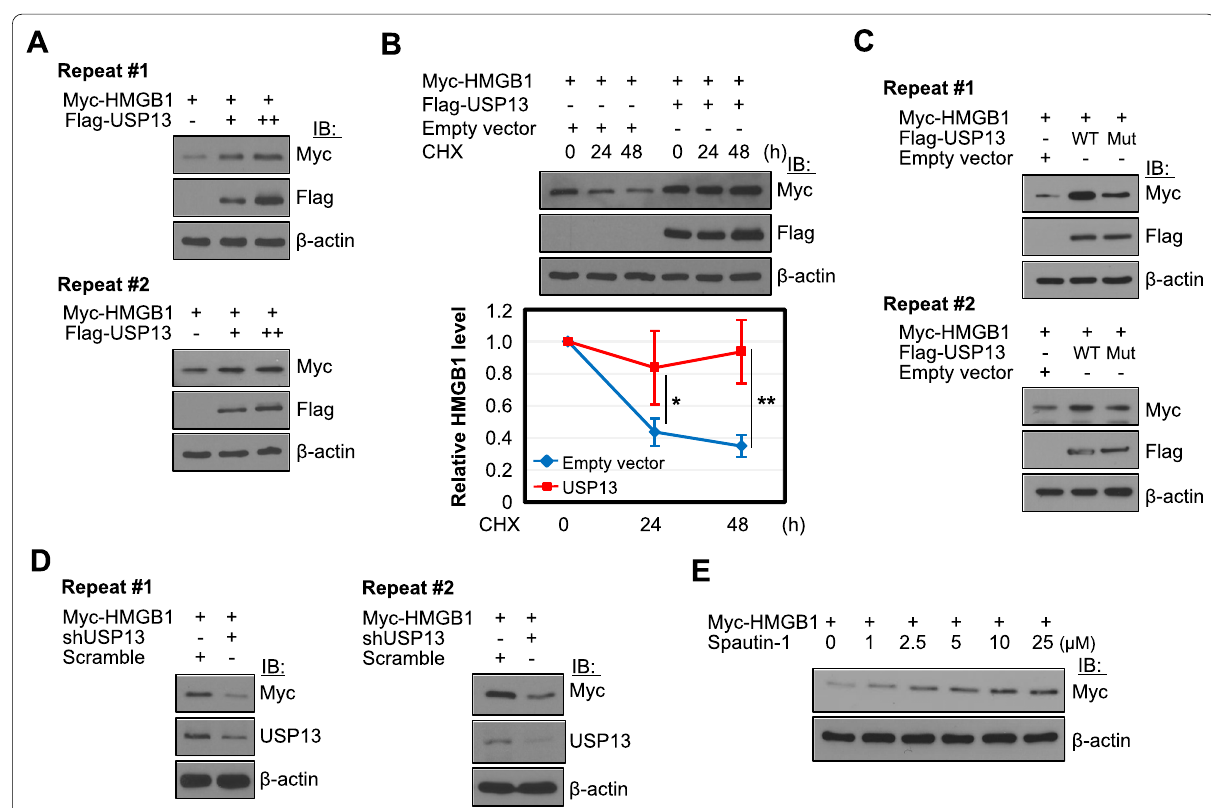
Fig. 4 The levels of HMGB1 protein are increased by USP13. A HEK293T cells were co‑transfected with both Myc‑HMGB1 and various doses of Flag‑USP13 plasmids and WCLs were then immunoblotted. B HEK293T cells were co‑transfected with both Myc‑HMGB1 and Flag‑USP13 plasmids, and then treated with 100 μg/mL cycloheximide (CHX) for the indicated times and WCLs were immunoblotted. * p < 0.05, ** p < 0.01 using two‑tailed Student’s t ‑test. C , D HEK293T cells were co‑transfected with Myc‑HMGB1 and USP13C345A/M664/739E (USP13 Mut) C and shUSP13 for 48 h ( D ). WCLs were immunoblotted. E HEK293T cells were transfected with Myc‑HMGB1 plasmid for 48 h, and then treated with Spautin‑1 for the last 18 h indicated dose and WCLs were